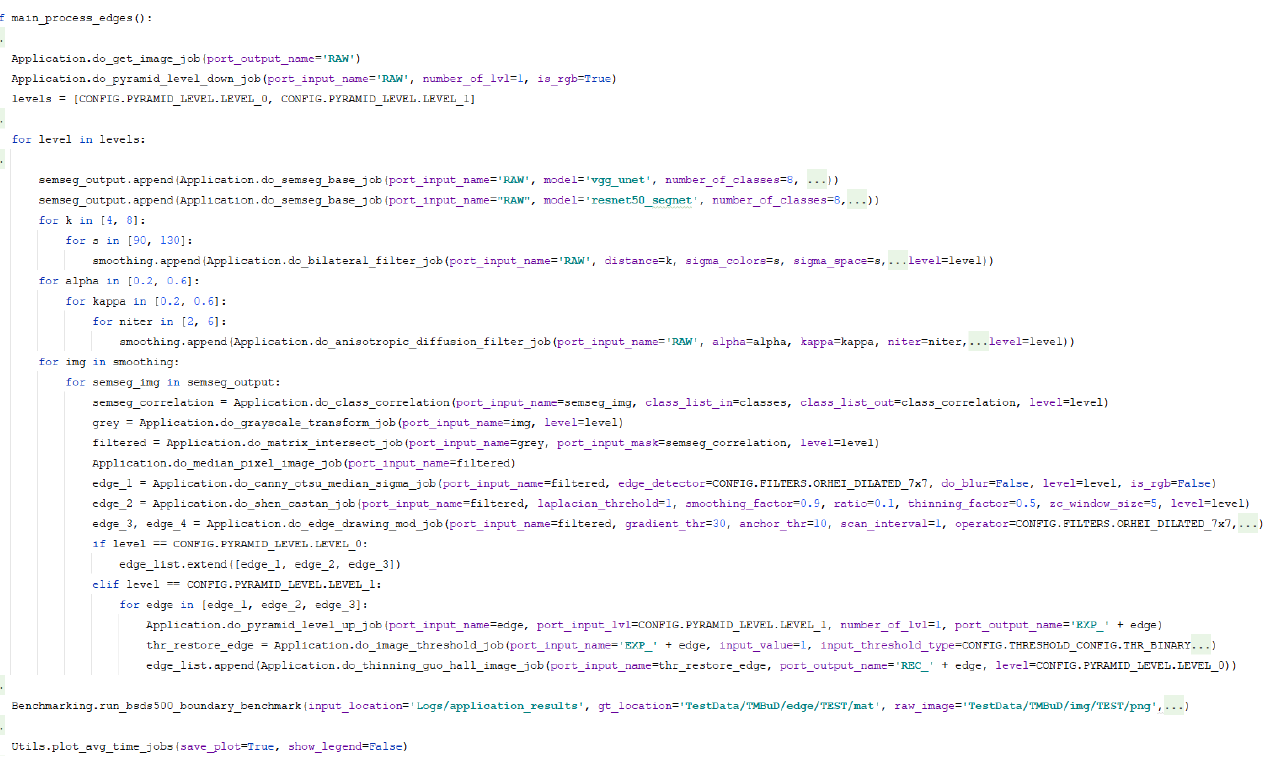
Figure 20. Setup in EECVF of the